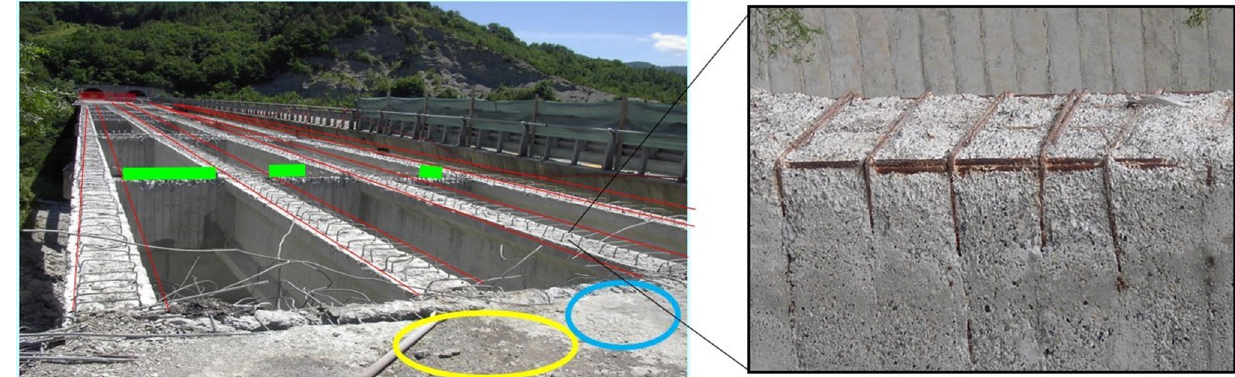
waterproofing materials; coloured in blue the dark asphalt layer; on the right pane the internal steel